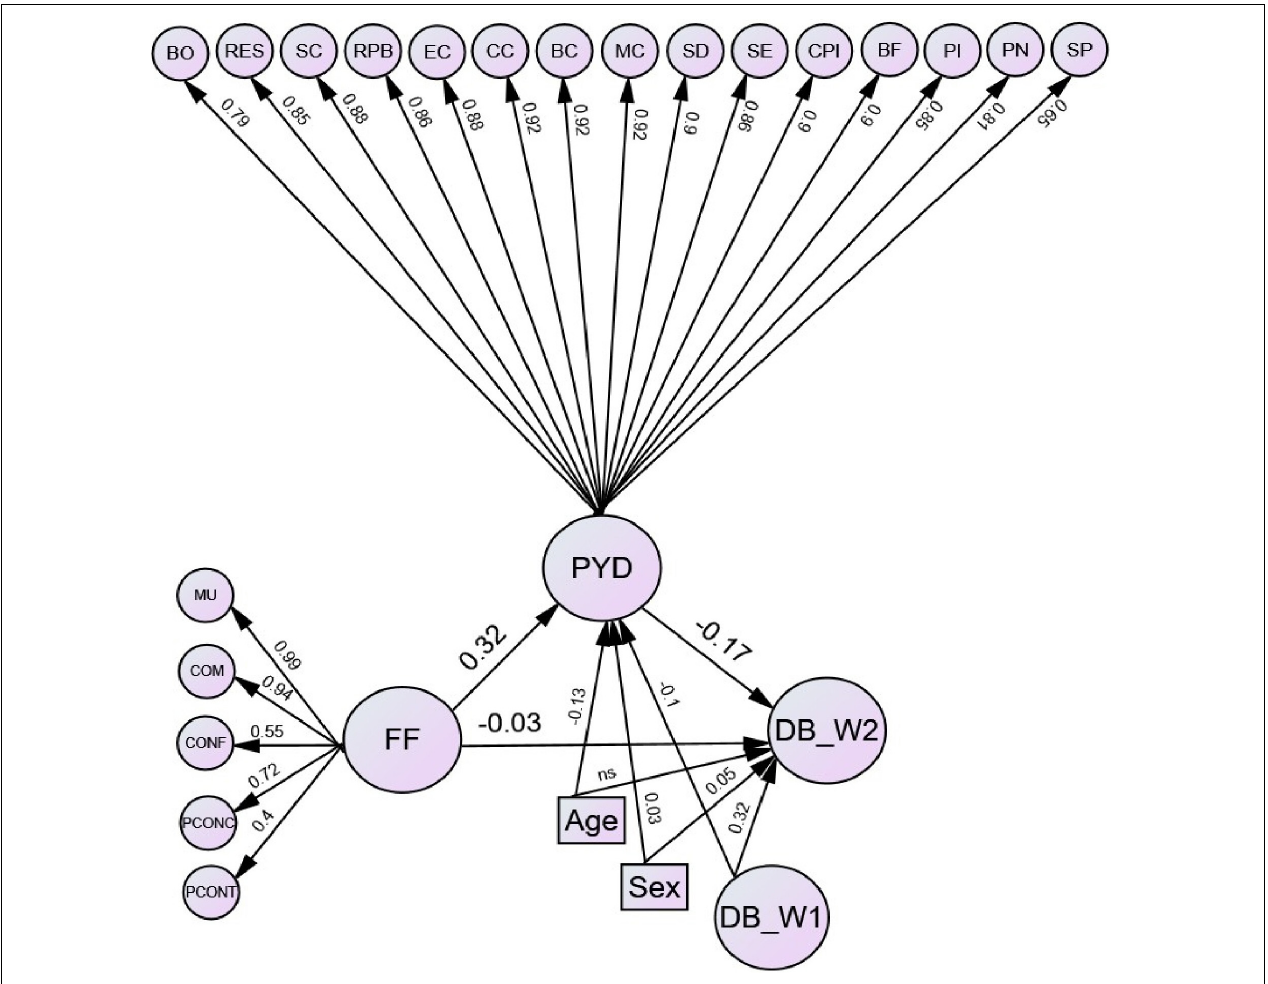
FIGURE 3 | Mediation model of positive youth development at Wave 2 on the path from family functioning at Wave 1 to delinquency at Wave 2 when controlling for age, gender, and delinquency score at Wave 1. Note: Standardized estimates are shown in the figure. All paths were significant at 0.05 levels except for the path from age to DB_W2. Indicators of all latent variables, correlations among the factors of family functioning, and correlations among covariates were omitted for clarity. DB_W2, delinquency at Wave 2; MU, mutuality; COM, communication; CONF, conflict and harmony; PCONC, parental concern; PCONT, parental control; FF, family functioning; BO, bonding; RES, resilience; SC, social competence; RPB, recognition for positive behavior; EC, emotional competence; CC, cognitive competence; BC, behavioral competence; MC, moral competence; SD, self-determination; SE, self-efficacy; CPI, clear and positive identity; BF, beliefs in the future; PI, prosocial involvement; PN, prosocial norms; SP, spirituality; PYD, positive youth development; Age, age; Sex, sex; and DB_Wl, delinquency at Wave